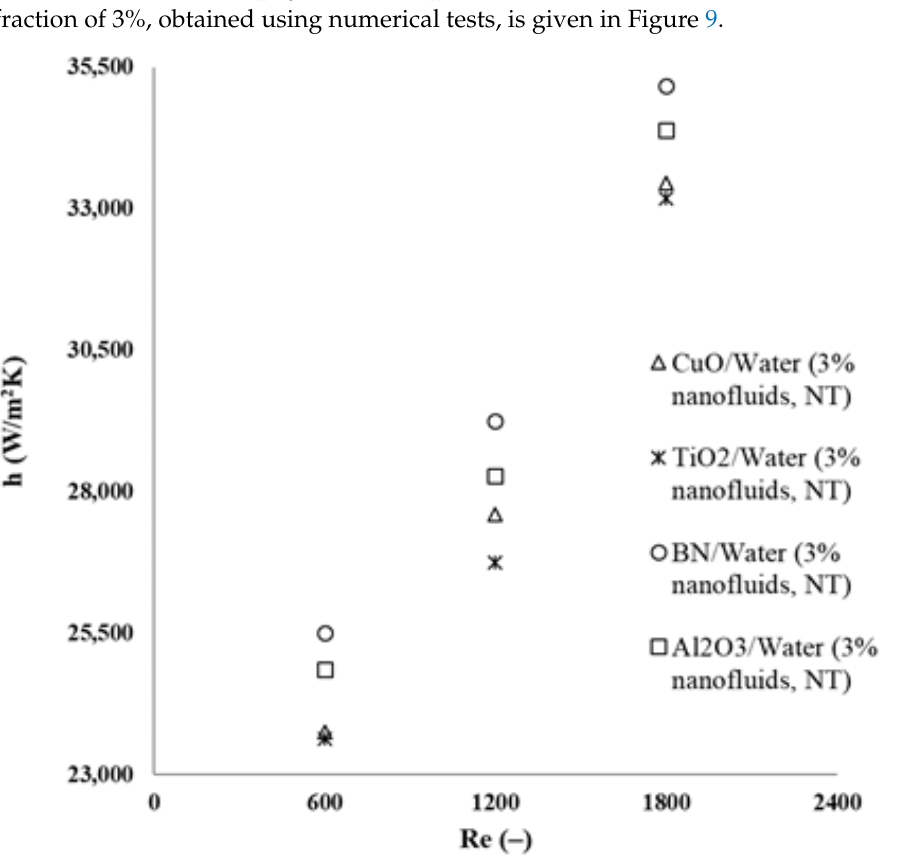
Figure 9. Comparison of the heat transfer coefficients values for different Reynolds numbers obtained using numerical tests (NT).